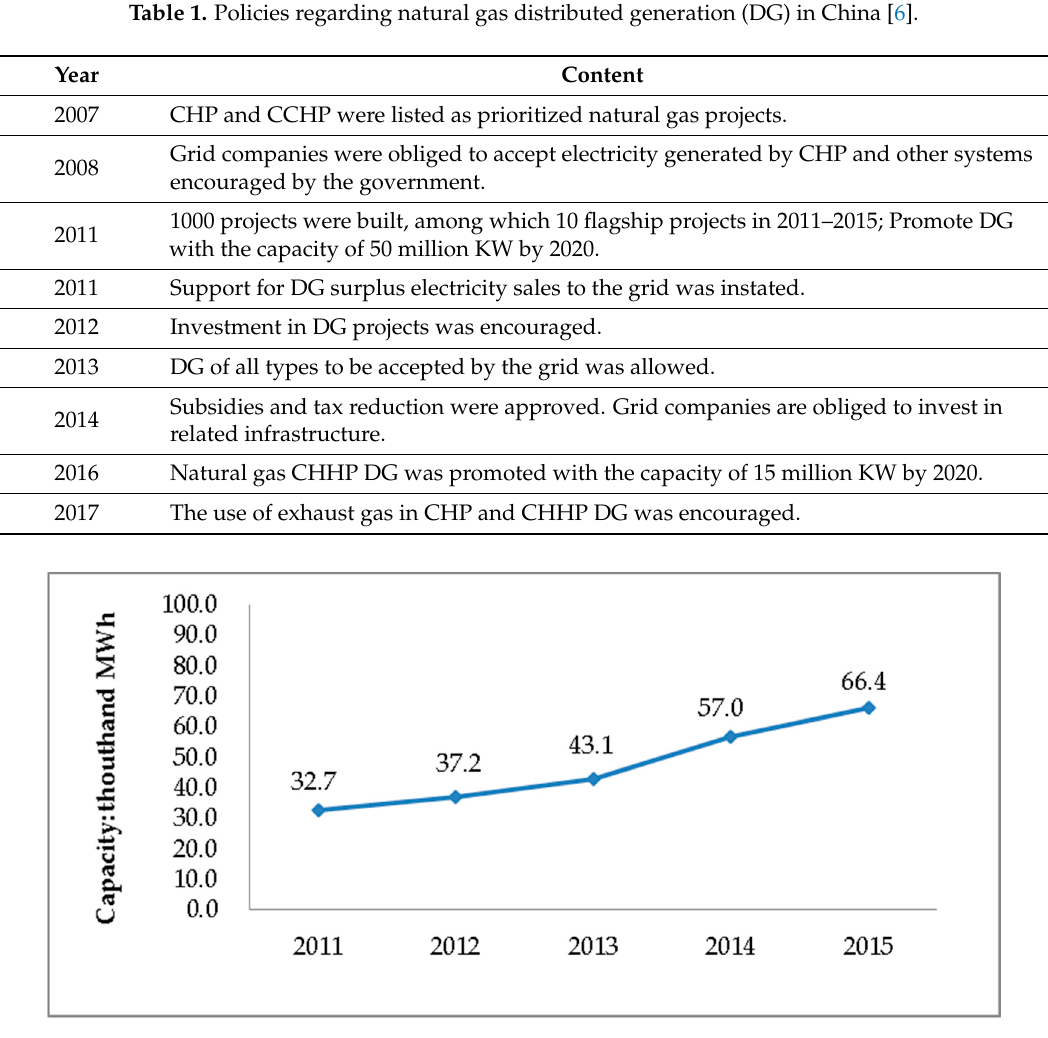
Figure 2. Increase in China natural gas distributed generation capacity between 2011 and 2015 [7].